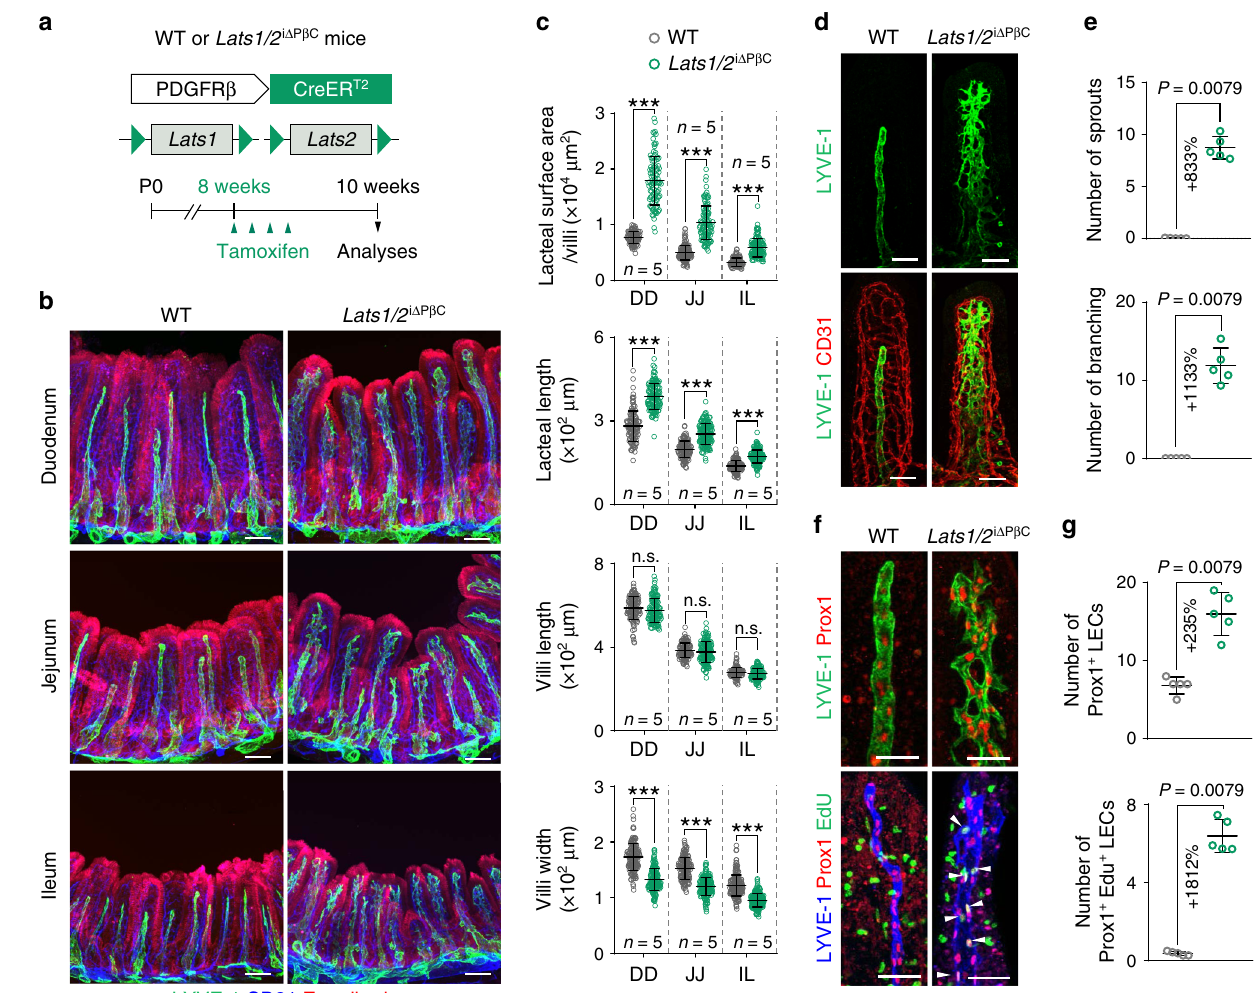
Fig. 1 YAP/TAZ hyperactivation in PDGFR β + IntSCs induces lacteal sprouting and branching. a Diagram depicting the generation of Lats1 / 2 i Δ P β C mouse and PDGFR β + cell-speci fi c depletion of Lats1/2 in 8-week-old mice and analyses at 2 weeks later. b , c Representative images of LYVE-1 + lacteals and CD31 + capillary plexus under the E-cadherin + epithelial cells in intestinal villi of the indicated part of small intestine and comparisons of the lacteal surface area per villi, lacteal length, villi length, and villi width in the duodenum (DD), jejunum (JJ), and ileum (IL) in WT and Lats1/2 i Δ P β C mice. Dots indicate values of 101 – 217 villi/group in n = 5 mice/group pooled from three independent experiments. Horizontal bars indicate mean ± SD and *** P < 0.0001 versus WT by two-tailed Mann – Whitney U test. n.s., not signi fi cant. Scale bars, 100 μ m. d , e Representative images and comparisons of the number of lacteal sprouts and branches per 100 μ m of lacteal length in WT and Lats1/2 i Δ P β C mice. Each dot indicates a mean value of 10 – 20 villi/mouse and n = 5 mice/group pooled from three independent experiments. Horizontal bars indicate mean ± SD and P value versus WT by two-tailed Mann – Whitney U test. Scale bars, 50 μ m. f , g Representative images and comparisons of the number of Prox1 + lymphatic endothelial cells (LECs) and Prox1 + EdU + proliferative LECs (white arrowheads) per 100 μ m of lacteal length in WT and Lats1/2 i Δ P β C mice. Each dot indicates a mean value of 10 – 20 villi/mouse and n = 5 mice/group pooled from three independent experiments. Horizontal bars indicate mean ± SD and P value versus WT by two-tailed Mann – Whitney U test. Scale bars, 50 μ